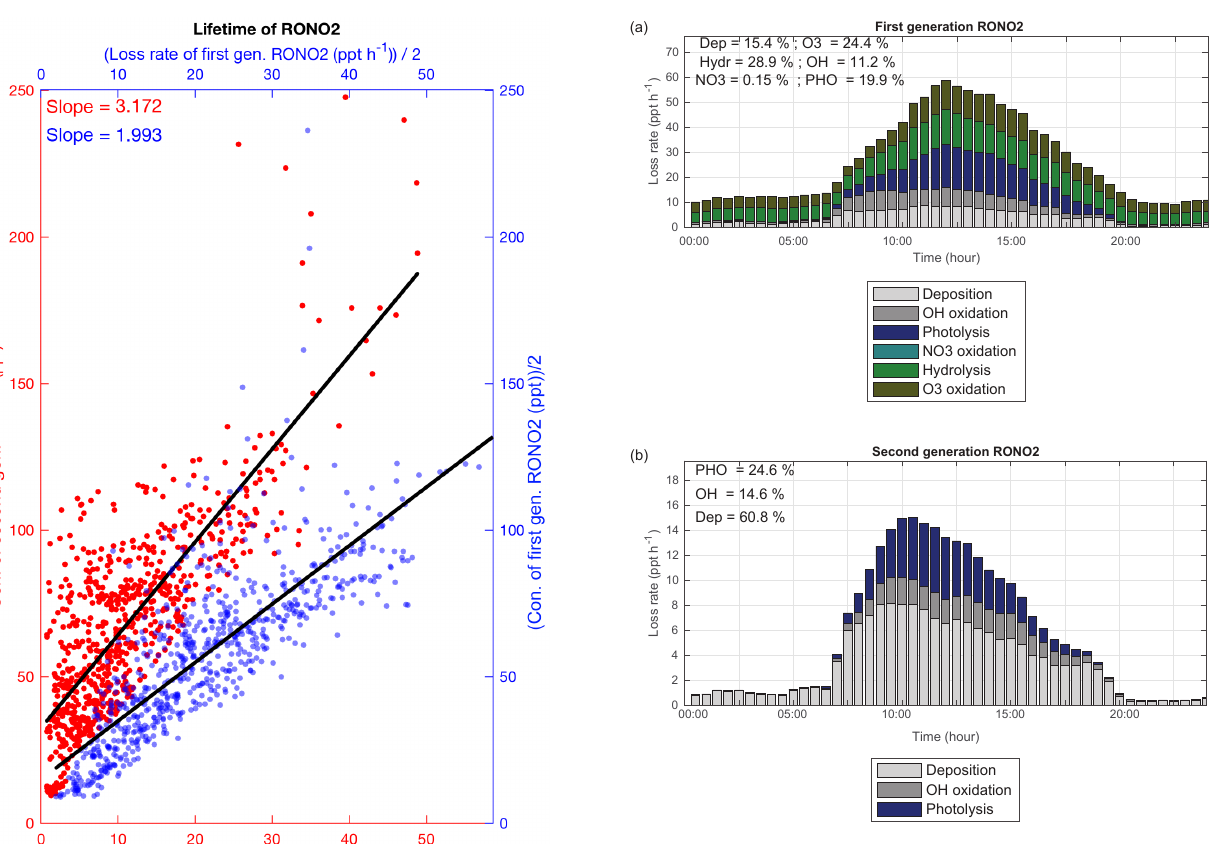
Figure 10. Contribution of different fates to (a) the first and (b) sec- ond generation of isoprene and monoterpene nitrates